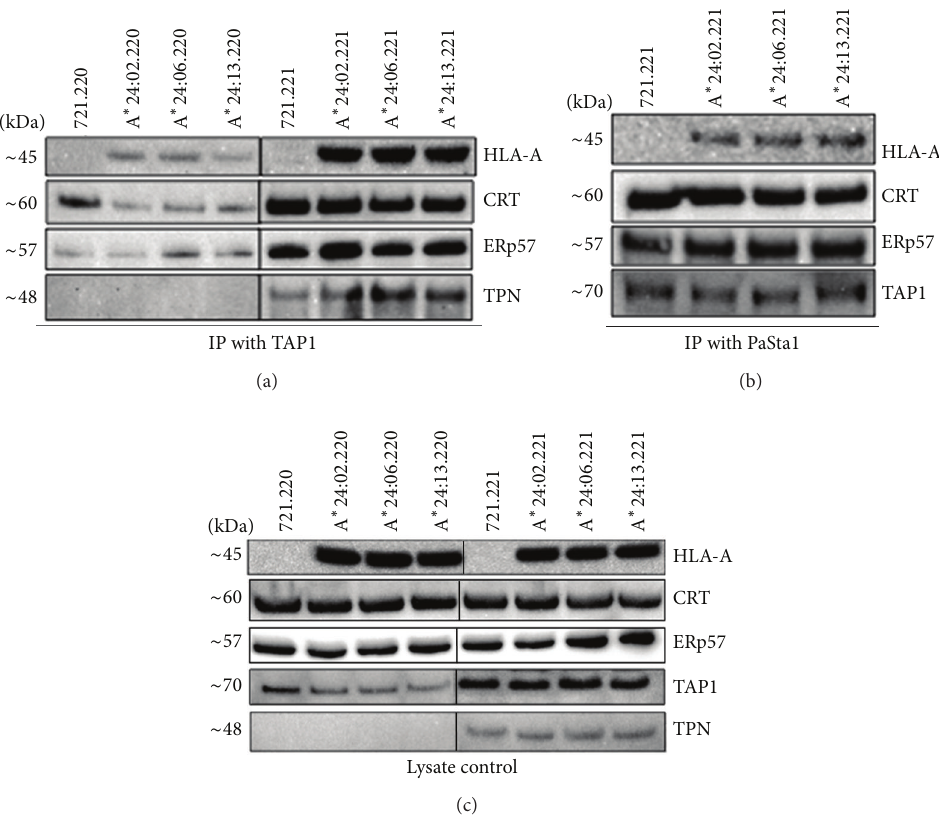
Figure 3: HLA-A ∗ 24/156 variants are associated at similar levels with TAP and TPN. Lysates from HLA-A ∗ 24 transduced 721.221 cells were immunoprecipitated with TAP1 (Figure 3(a)) or with PaSta-1 (anti-TPN) antibody (Figure 3(b)). The immunoprecipitates were subjected to SDS-PAGE and transferred to PVDF membranes that were probed with antibody against HLA-A heavy chain, CRT, ERp57, TPN, and TAP1. All the 3 HLA-A ∗ 24/156 variants showed similar levels of association with TPN in 721.221 cells indicating that they make use of TPN when it is present (Figure 3(b)). HLA-A ∗ 24/156 variants showed strong associations with TAP1 in 221 cells (Figure 3(a)). They were weakly associated with TAP1 in 220 cells lacking functional TPN. Lysate controls showed decreased steady state TAP1 levels in 220 cells compared to 221 cells (Figure 3(c)). Lysate controls showed similar levels of HLA-A24, CRT, and ERp57 in all the transduced 721.220 and 721.221 cells (Figure 3(c)) and similar levels of TPN in all the transduced 721.221